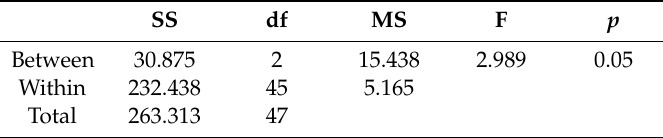
Table 6. The ANOVA result of assembly errors.